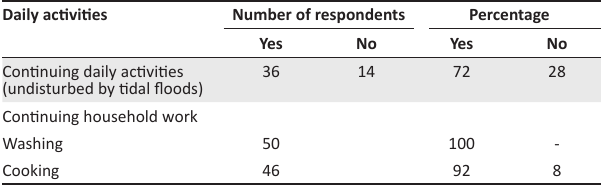
FIGURE 7: Embankment construction along the coastline.